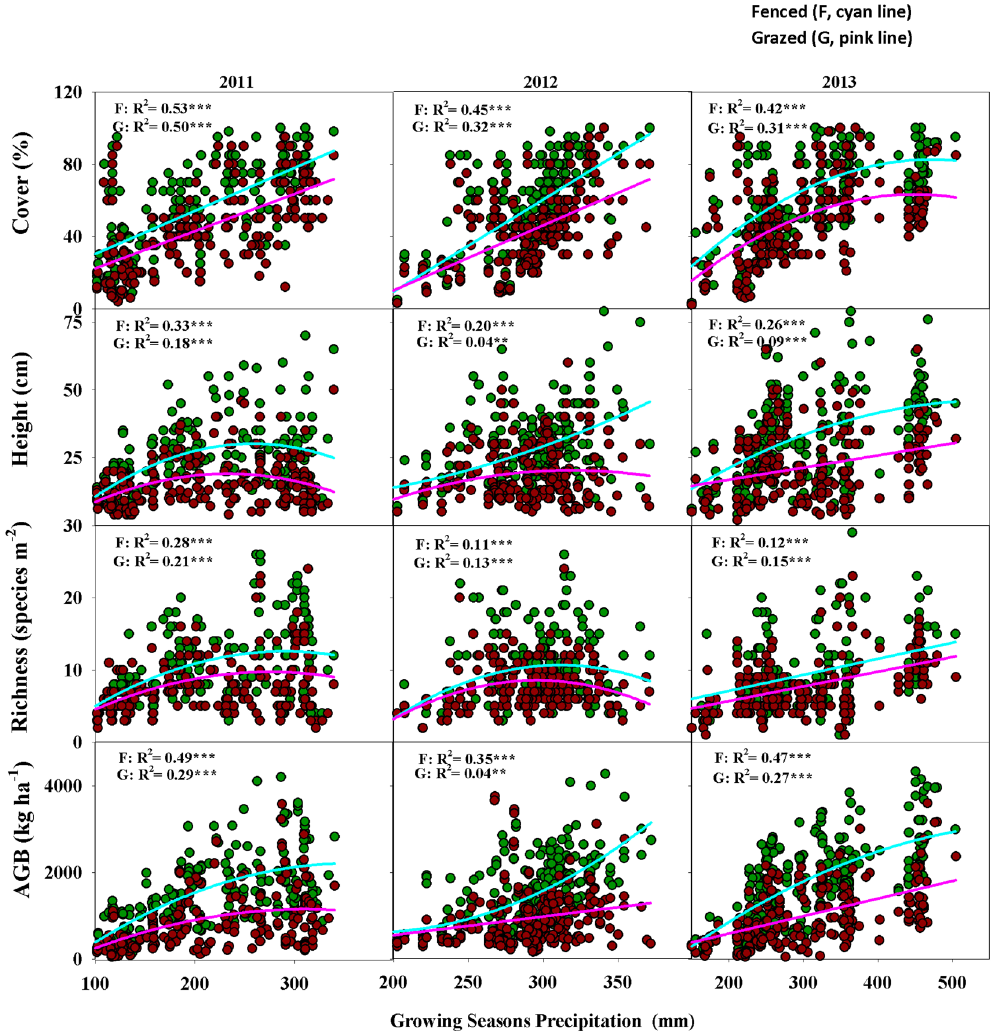
Figure 4. Relationship between vegetation cover, height, richness, aboveground biomass (AGB) and growing season precipitation at both fenced ( F ) and grazed ( G ) sites. * P -value < 0.05, ** P -value < 0.01, *** P - value < 0.0001. MS: meadow steppe; TS: typical steppe; DS: desert